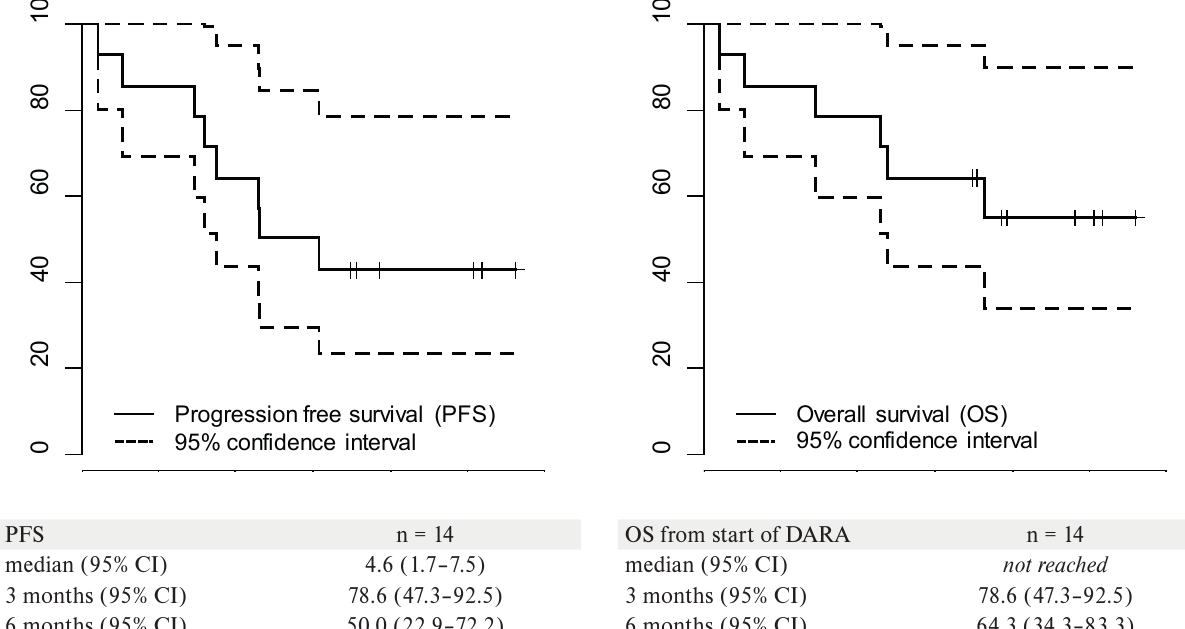
Fig. 1. Progression free survival and overall survival in advanced relapsed and/or refractory multiple myeloma treated by daratu- mumab